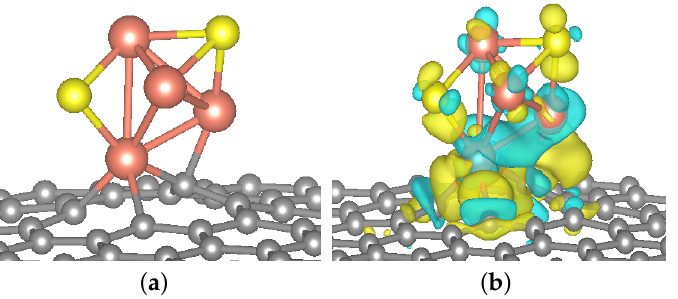
Figure 2. The optimized structure ( a ) and charge density difference plot ( b ) for the Cu 4 S 2 /SV catalyst. The yellow and blue color regions mean the charge accumulation and depletion,